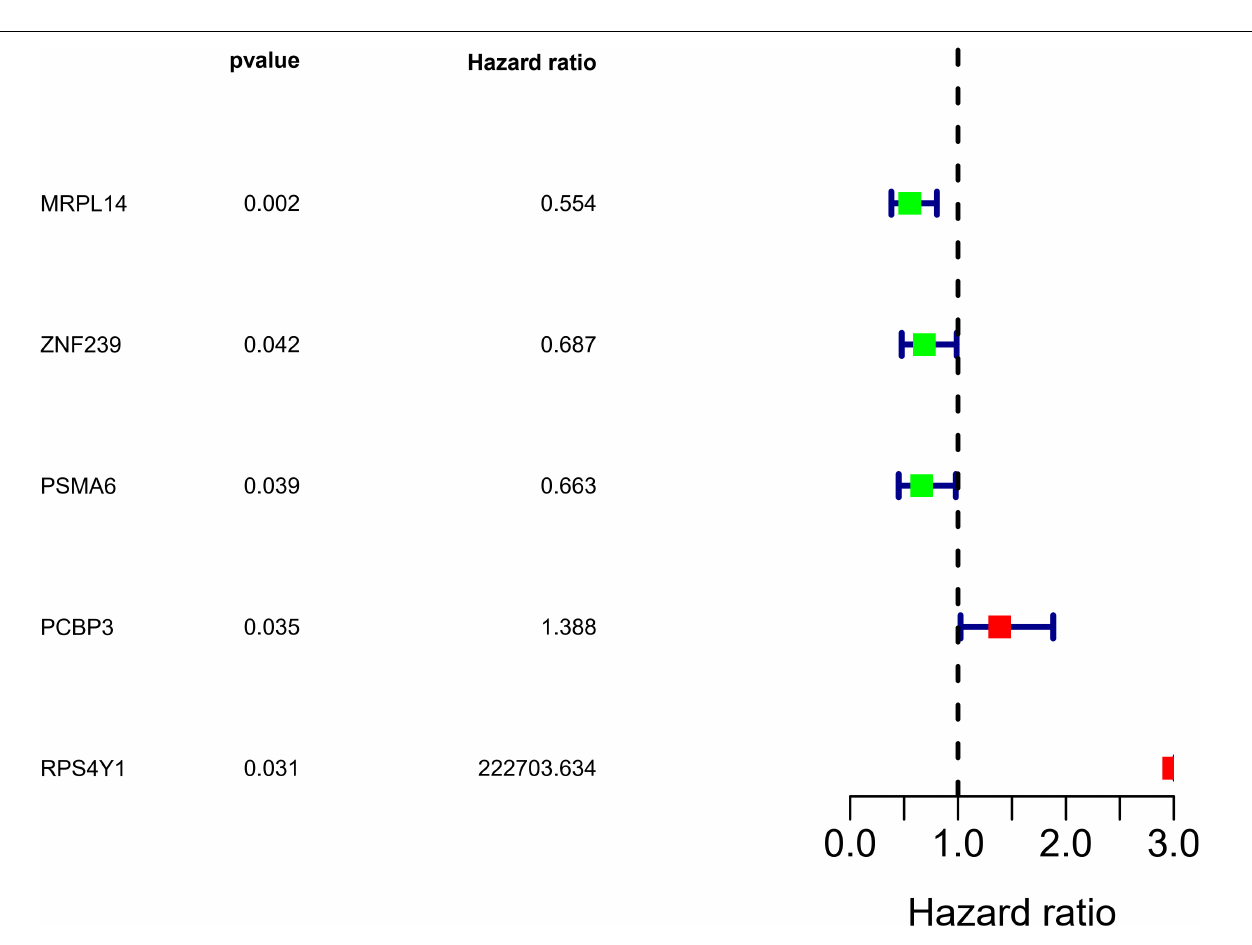
FIGURE 5 | Identification of prognosis-related RBPs by multivariate Cox regression